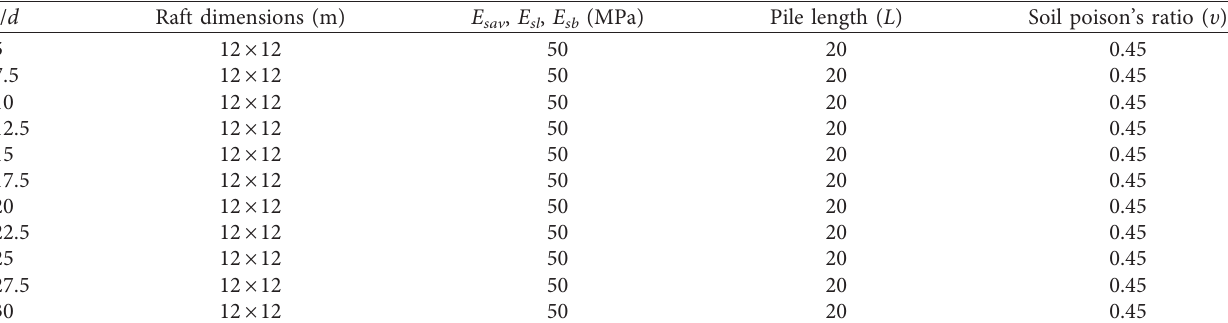
Figure 9: Cross-section for M11 moment on eight-story side: (a) with piles; (b) without piles. Table 7: Parameters